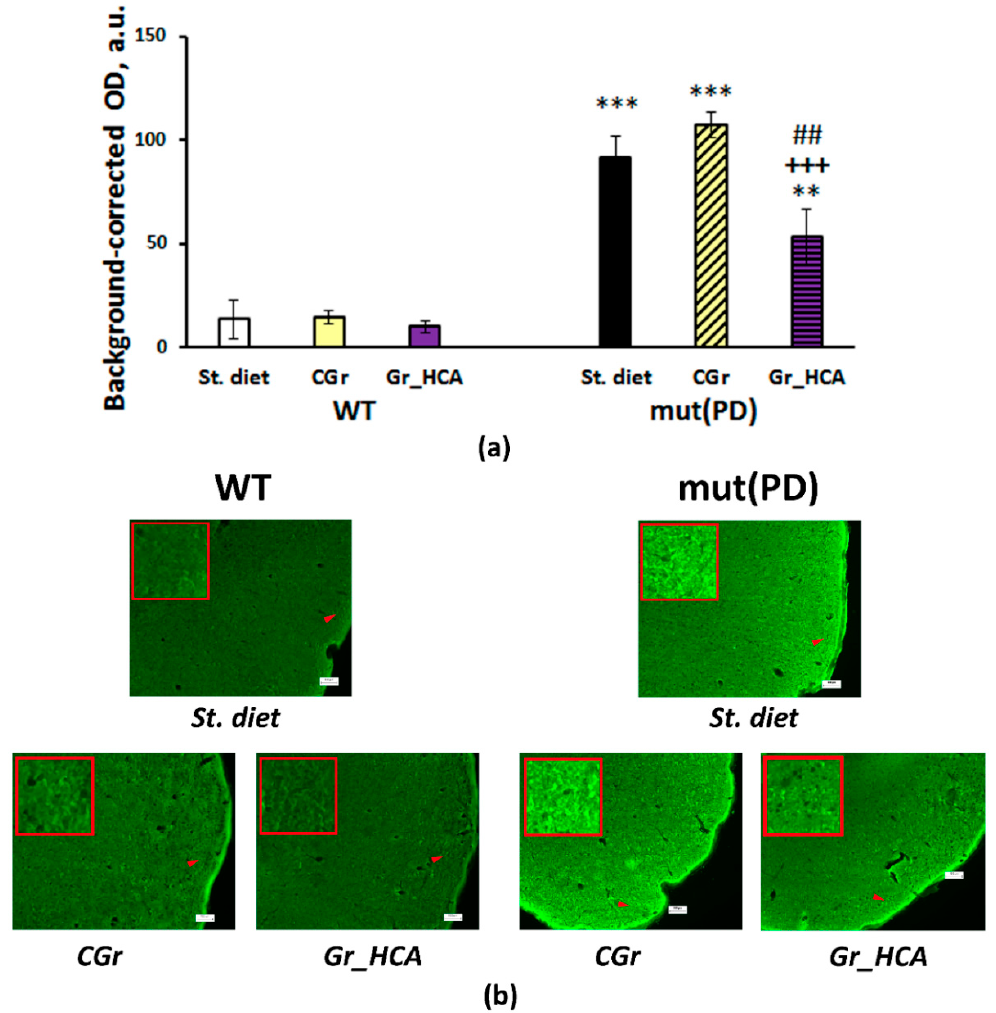
Figure 4. Effects of the type of diet and overexpression of α -synuclein (genetic PD model) on the α -synuclein accumulation in the frontal cortex in mice. ( a ) Quantitative results. The data are expressed as the means ± SEMs of the values obtained in an independent group of animals ( n = 3–4 per group). Statistically significant differences: ** p < 0.01, *** p < 0.001 vs. a respective WT group; ## p < 0.01 vs. a respective group of mut(PD) mice given the standard diet (“mut(PD) + St. diet”); +++ p < 0.001 vs. a respective group of mut(PD) mice given the control grain diet (“mut(PD) + CGr”). ( b ) α -synuclein immunoreactivity in the frontal cortex. Magnification, 100 × ; bar, 100 µ m.